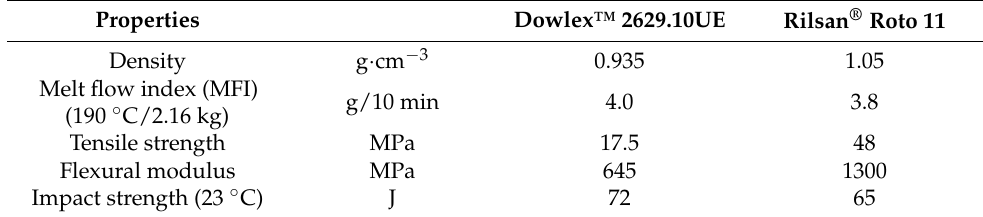
Table 1. Properties of used polymer